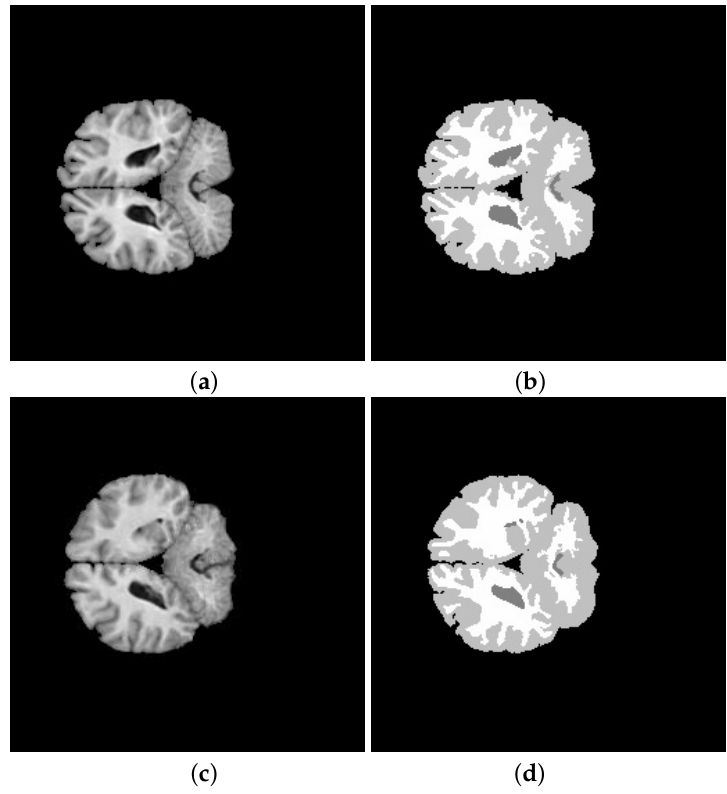
Figure 3. ( a ) Original image of Subject 202-3, Slice 20 and ( b ) its ground truth; ( c ) original image of Subject 205-3, Slice 20 and ( d ) its ground truth. Table 1. Parameters of the clustering algorithms. KFCM, Kernelized